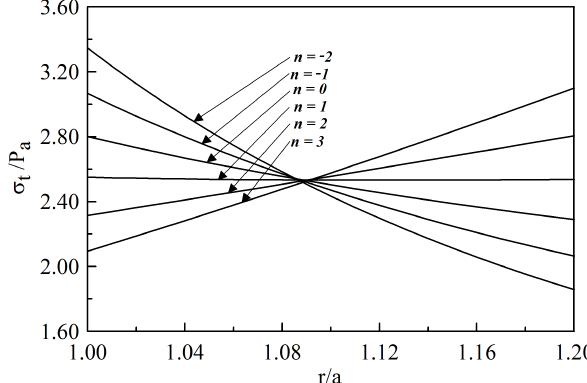
Figure 29: Radially distributed tangential stress